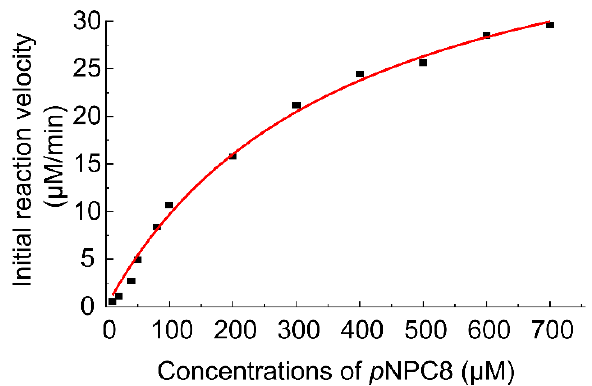
Figure 6. Michaelis–Menten kinetics of EstDR4. Enzymatic reaction kinetics of EstDR4 were tested with various concentrations (10~700 μ M) of pNPC8 as substrate.